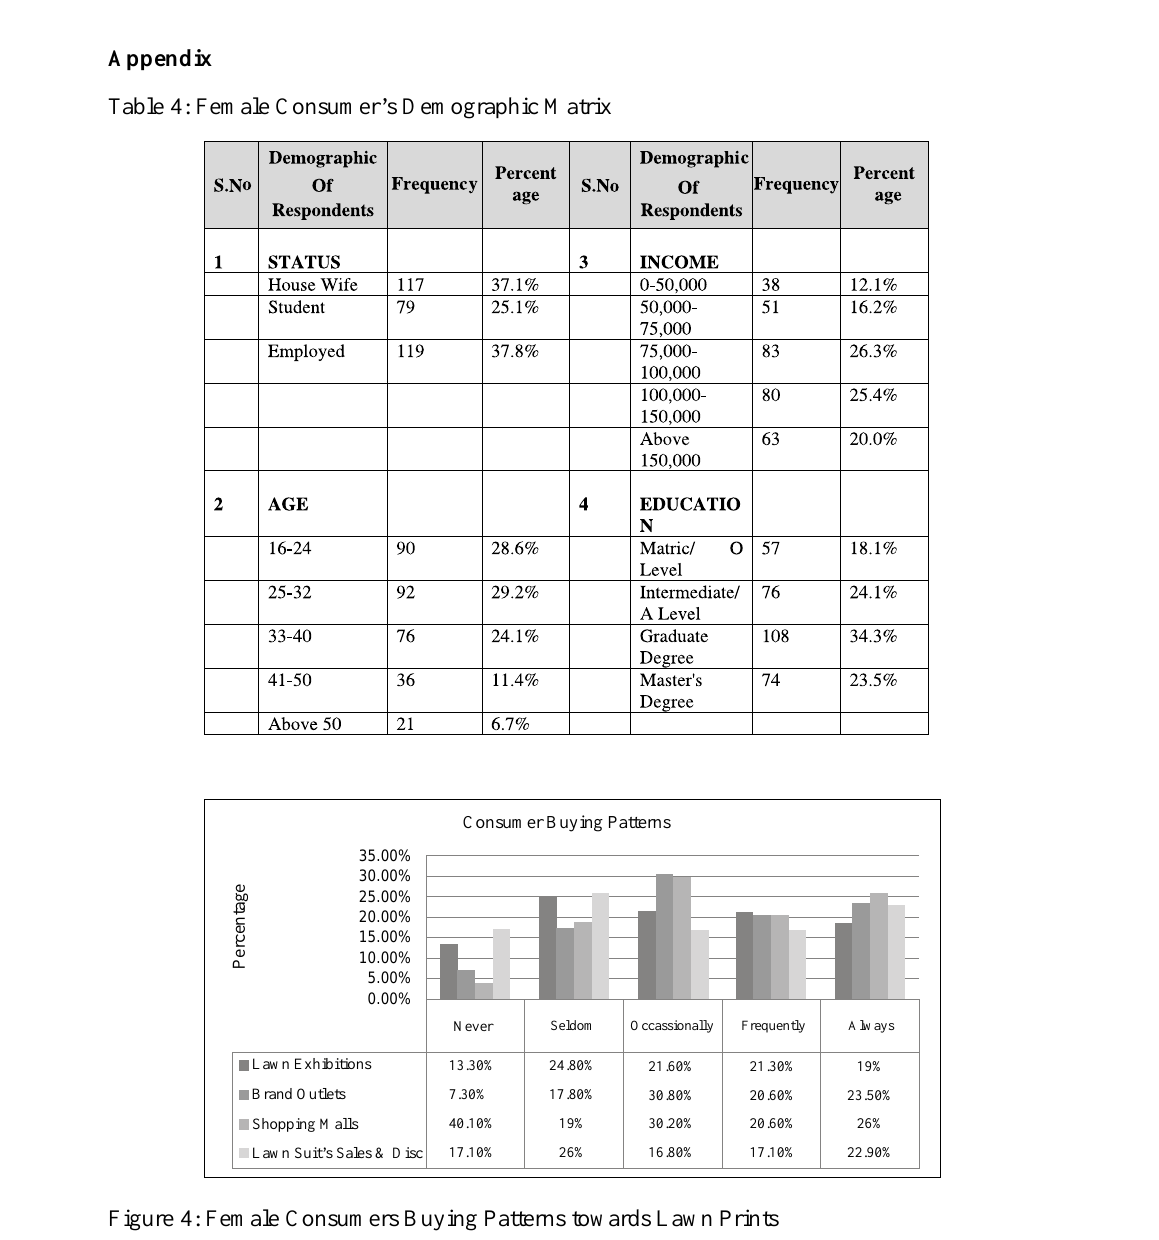
Table 4: Female Consumer’s Demographic Matrix